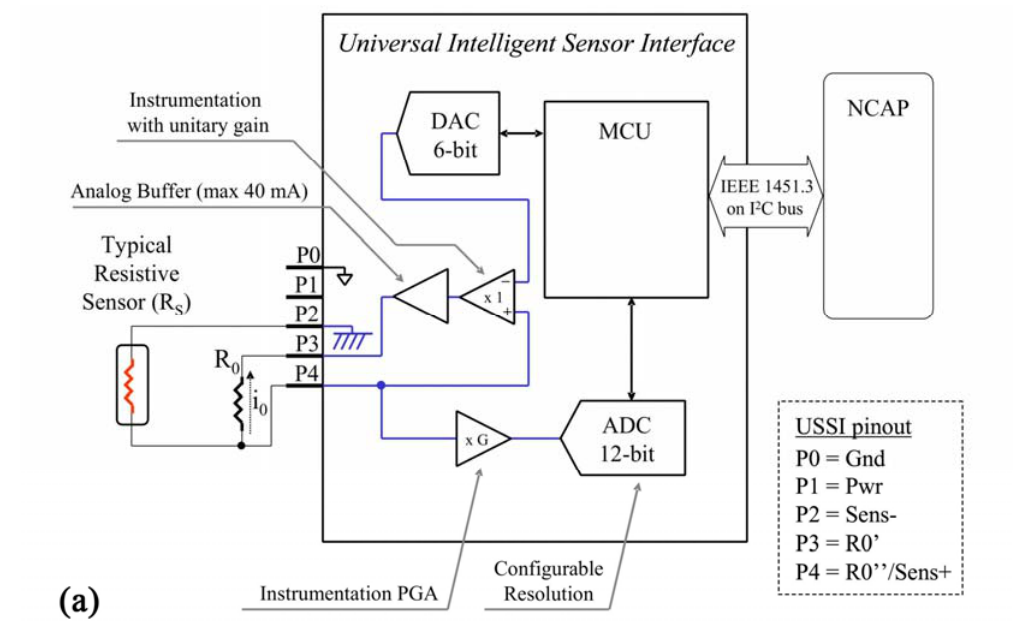
Figure 8. Resistive Sensors: (a) Logical scheme of UISI conditioning front-end and (b) screen-shot of related implementation in PSoC device through by means of Graphic